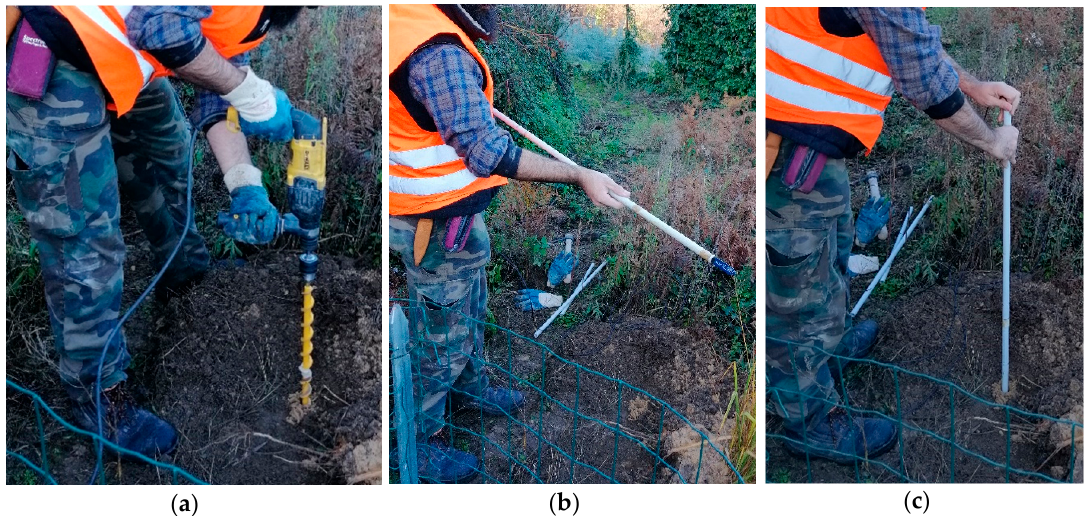
Figure 9. Vertical installation: ( a ) Creation of the vertical hole; ( b ) Positioning of the WaterScout in the PVC pipe; ( c ) Insertion of the sensor in the hole.